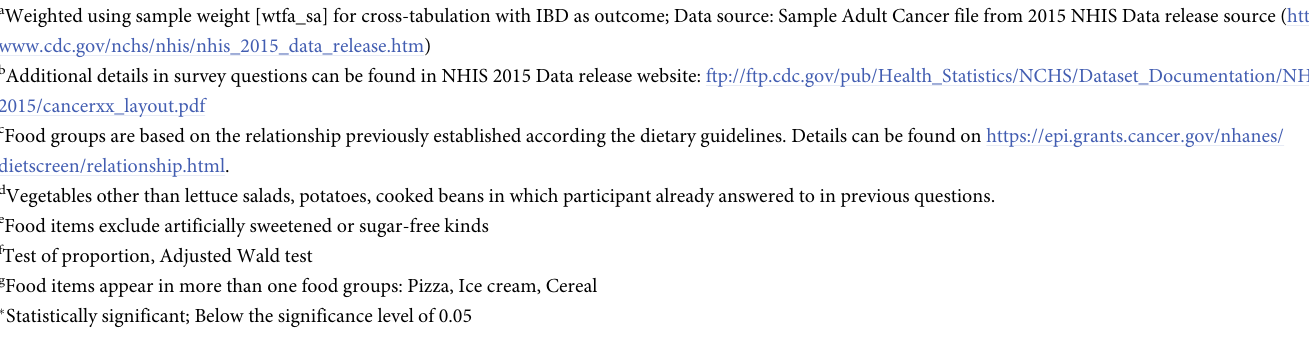
Weighted, Unadjusted IBD = Yes IBD =